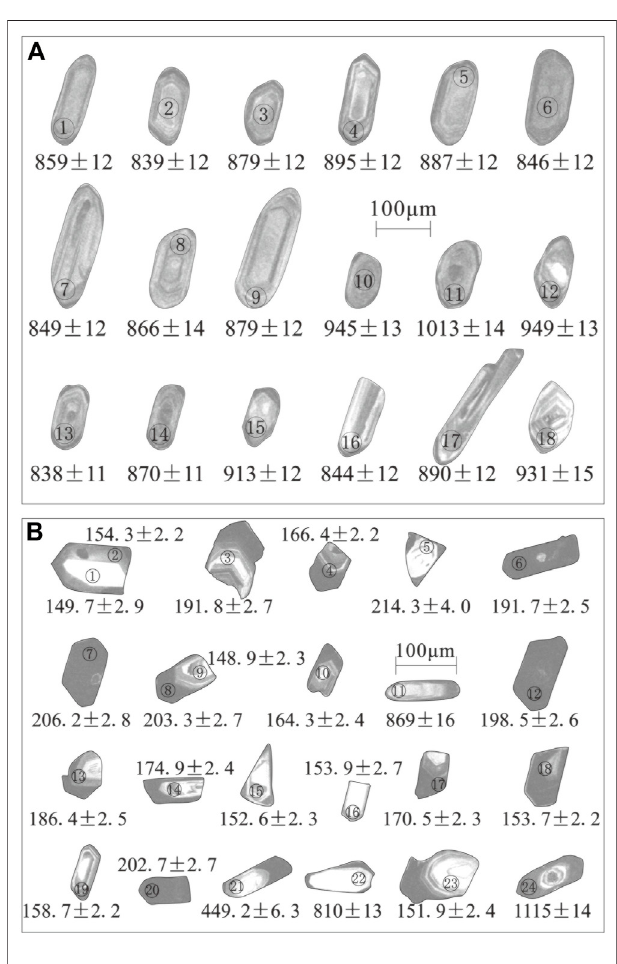
FIGURE 4 | CL imagines and 206 Pb/ 238 U ages of single Zircon of the granite dyke (Sample 1725) (A) and the granitic porphyry dyke (Sample 1717) (B)